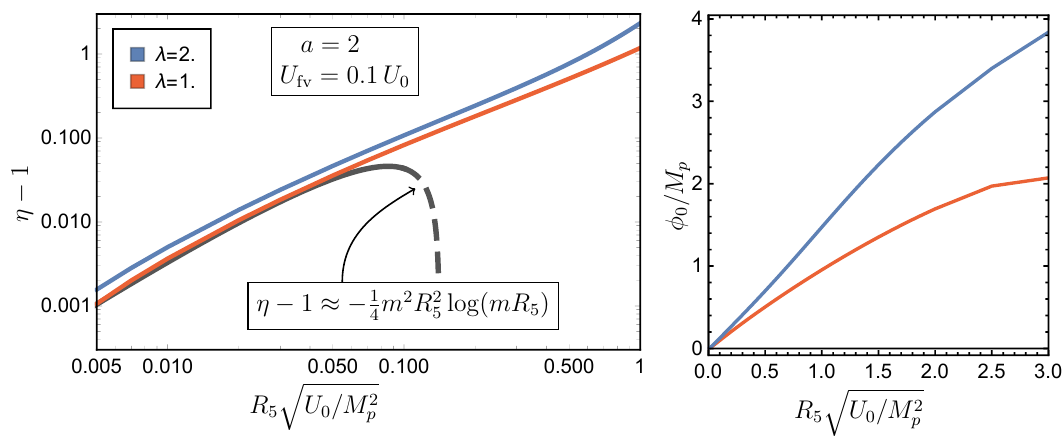
 ) Figure 35: Bounce solutions ⌘ ( R ) for U ( 5  Figure 14 . Shooting parameter solutions on the BON-FV branch for potentials dominated in the  compactification limit by exponentially growing contributions from a five-dimensional CC. Left: √ the value of the shooting variable η ≡ R is shown as a function of u 0 for two values of 3 /R 5 dimensionless parameter λ = Λ CC M 2 /U 0 ≤ 2 . 0 . The thick dashed line shows the theoretical p 5 expectation from the piecewise quadratic model, eq. (3.23), in the limit mR 1 , in terms of 5 (cid:28) √ the m 2 ∼ a 2 U of eq. (4.3). For 2 u 0 . 0 . 1 , the agreement is quite close, indicating that the 0 /M p exponentially growing potential has little effect on the shooting solution in this regime. As mR 1 5 → the corrections to η ≈ 1 are dominated by the O ( m 2 R 2 ) terms that are not logarithmically enhanced. 5 √ Right: here we show φ 0 , the alternative formulation of the initial conditions, as a function of u 0 , for the same values of λ . The λ = 1 . 0 and λ = 2 . 0 potentials (red and blue in the plot) do not have any CDL or HM solution, or any hybrid